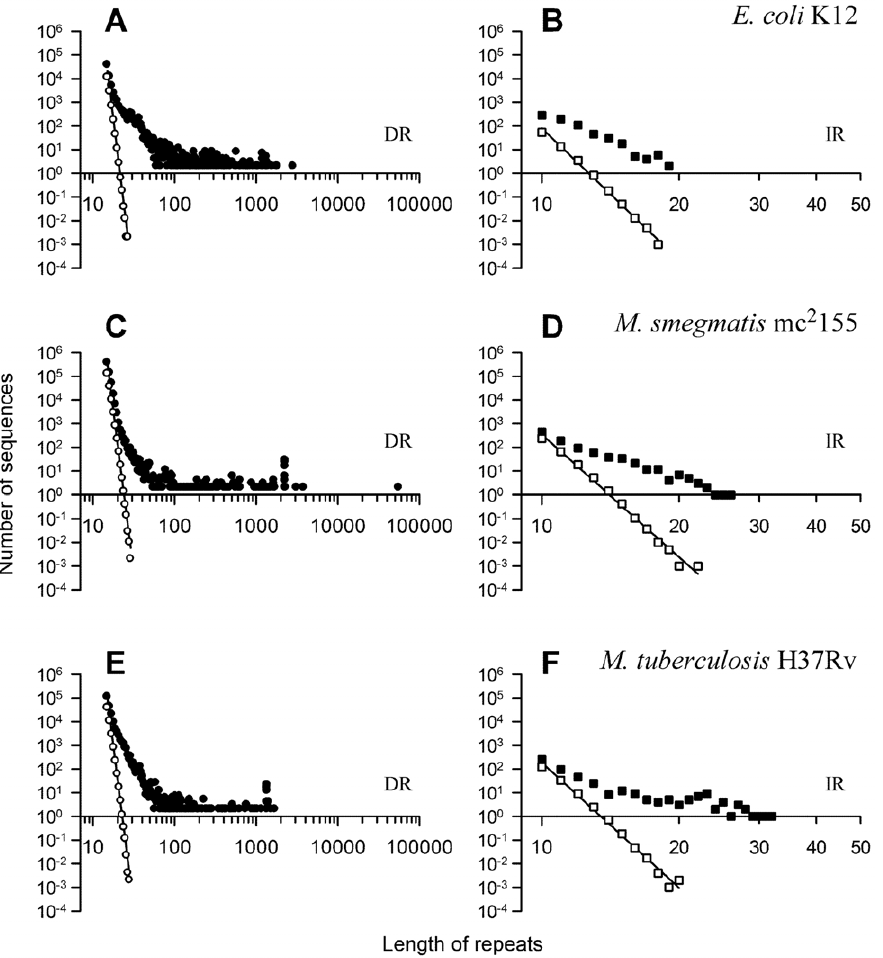
Figure 2. Direct and inverted repeats are overrepresented in mycobacterial and E.coli genomes. Genome-wide distributions of DRs and IRs. Panels A and B , E. coli K12; panels C and D , M. smegmatis ; panels E and F , M. tuberculosis ; left panels , direct repeats ( DR ); right panels , inverted repeats ( IR ); x-axes , length of repeats in nucleotides; y-axes , number of repeats; open symbols , predicted random distributions; closed symbols , observed